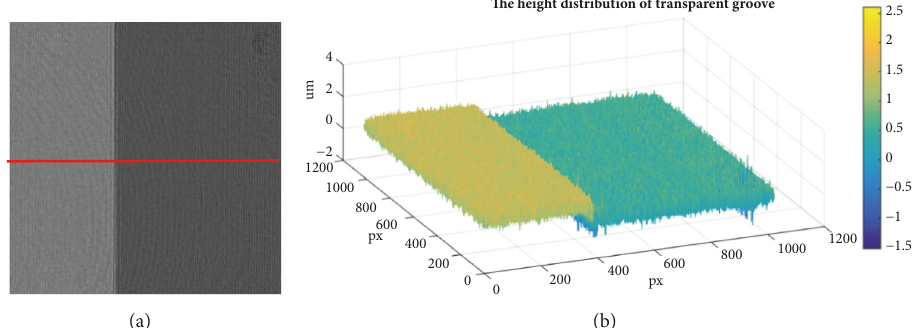
Figure 9: Results for equivalent wavelength. (a) Phase distribution, (b) three-dimensional height